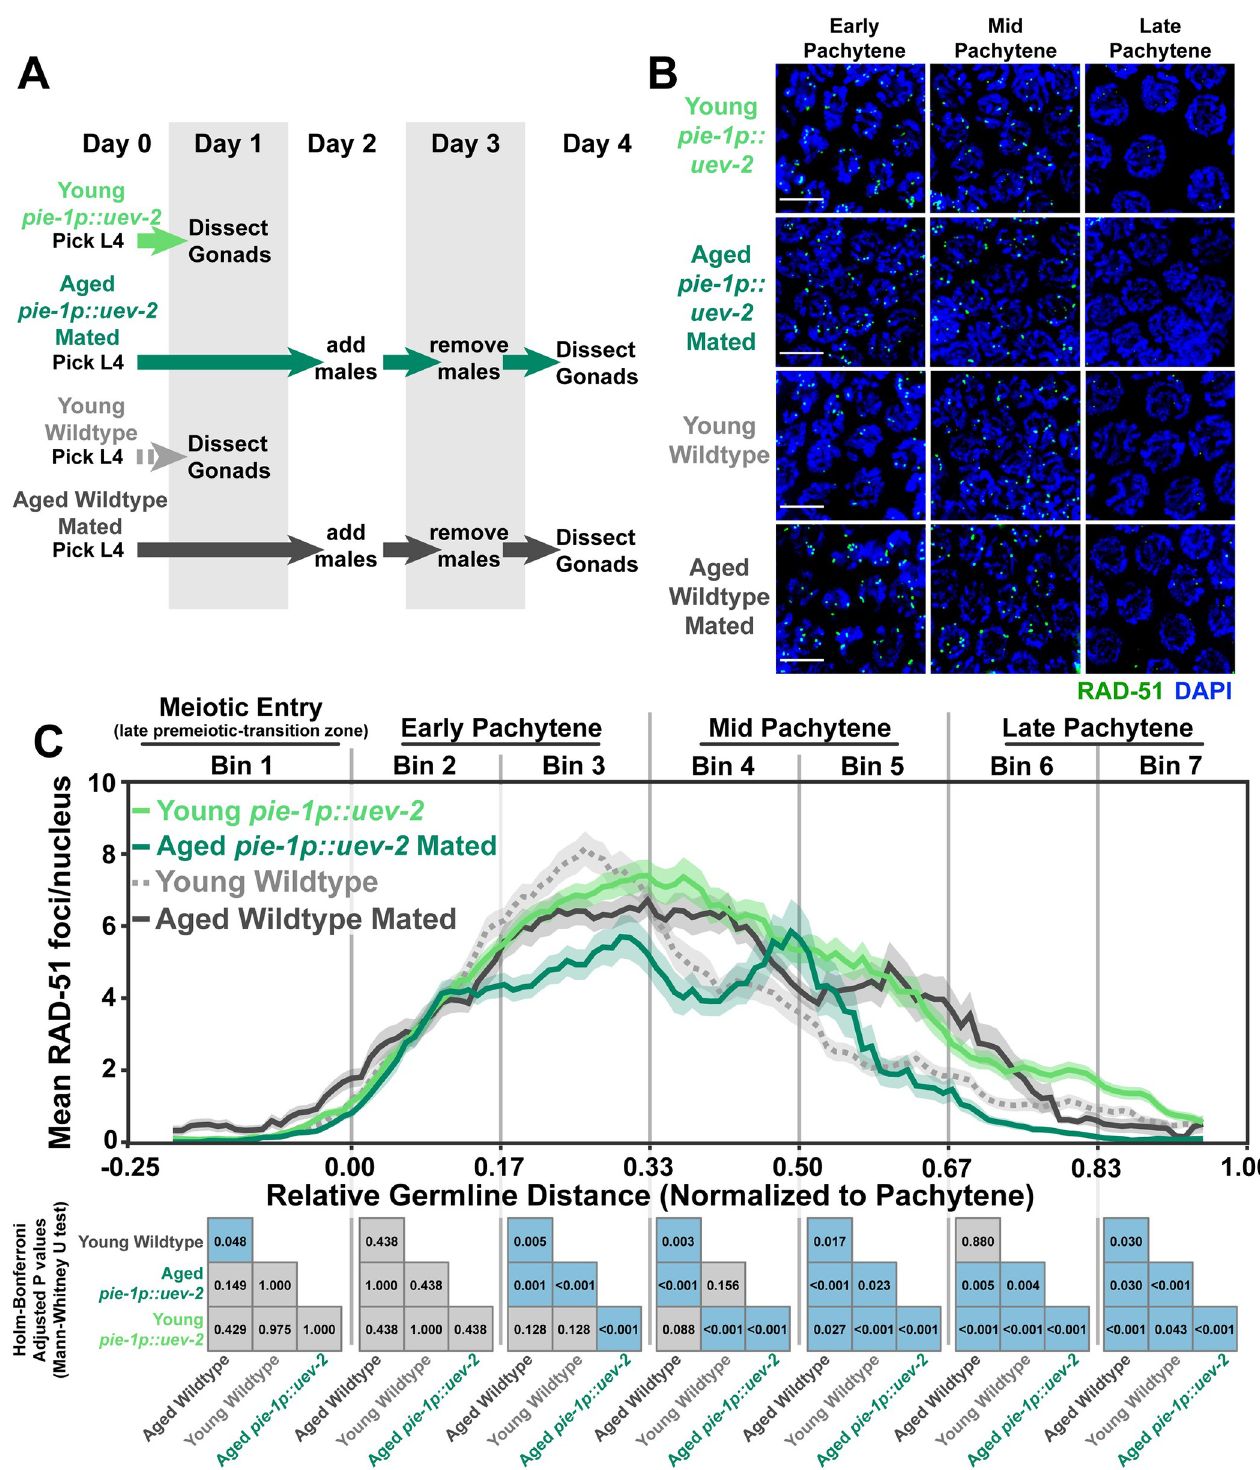
Fig 6. Germline uev-2 overexpression differentially impacts DSB levels in young and aged germlines. A) Schemes used to isolate young (1 day post-L4) and aged (4 days post L4) worms for experiments. Days count ~18–24 hour periods after hermaphrodites were isolated as L4 larvae and are separated by alternating grey shaded boxes. B) Representative images of RAD-51 foci in meiotic nuclei of young pie-1p :: uev-2 , aged pie-1 :: uev-2 , and young wildtype germlines. Scale bars represent 5 μ m. C) RAD-51 foci per nucleus in oocytes. Line plots represent the mean RAD-51 foci per nucleus along the length of the germline in a